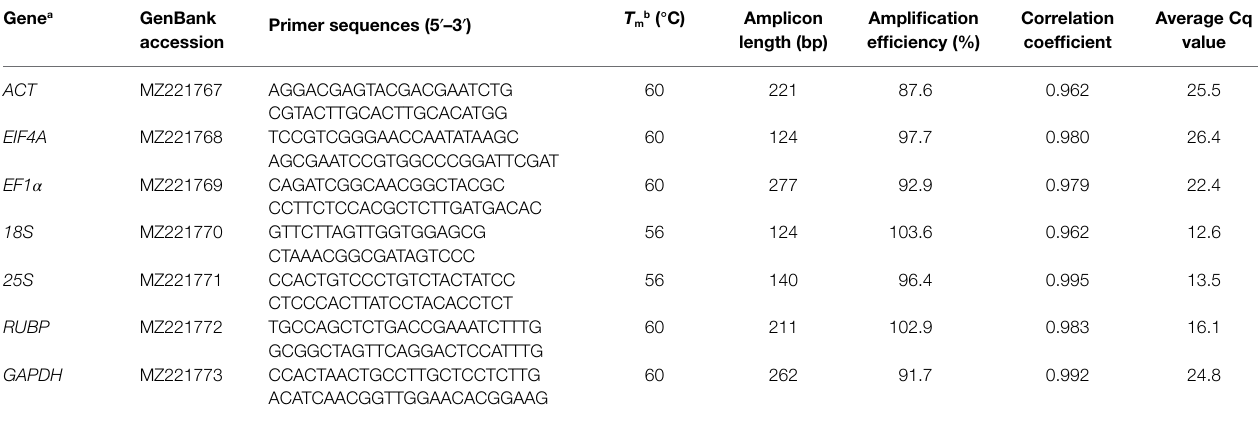
TABLE 1 | Basic characteristics of seven candidate reference genes for